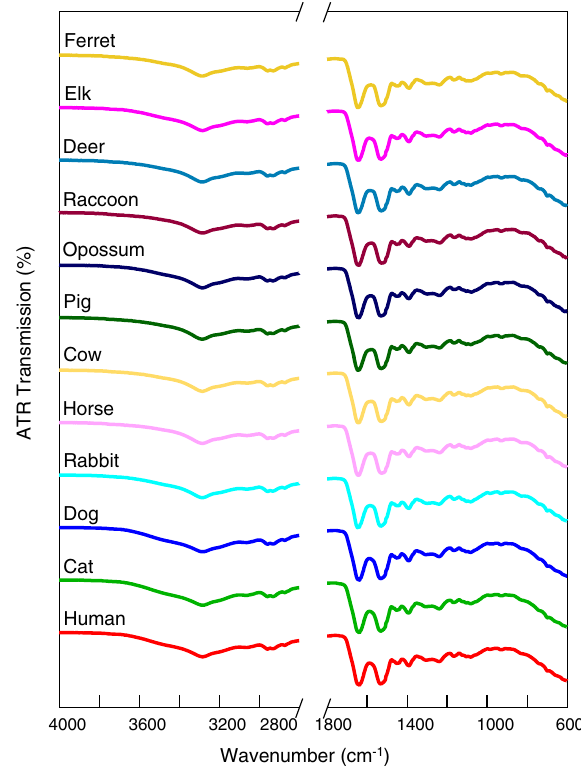
Fig. 1 The averaged raw ATR FT-IR spectra of blood for different species. Spectral ranges: 4000 – 2800 and 1800 – 600 cm − 1